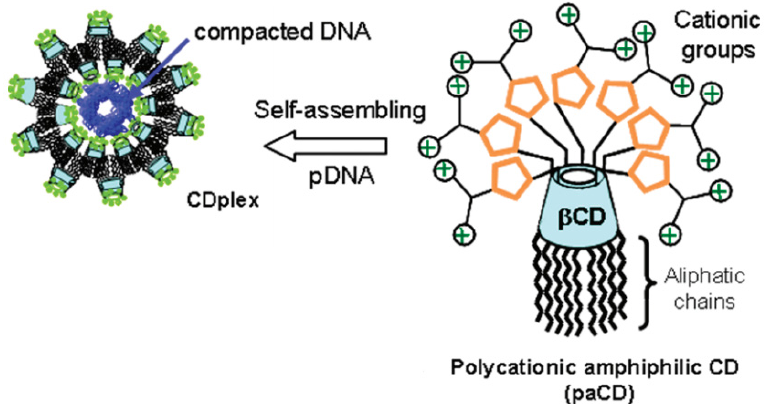
Figure 6. Schematic representation of polycationic amphiphilic cyclodextrins (CD) ( right ); which may form nanocomplexes (CDplexes) upon assembly with negatively charged pDNA ( left ) [80]. Reprinted with permission from [80]. Copyright (2011) American Chemical